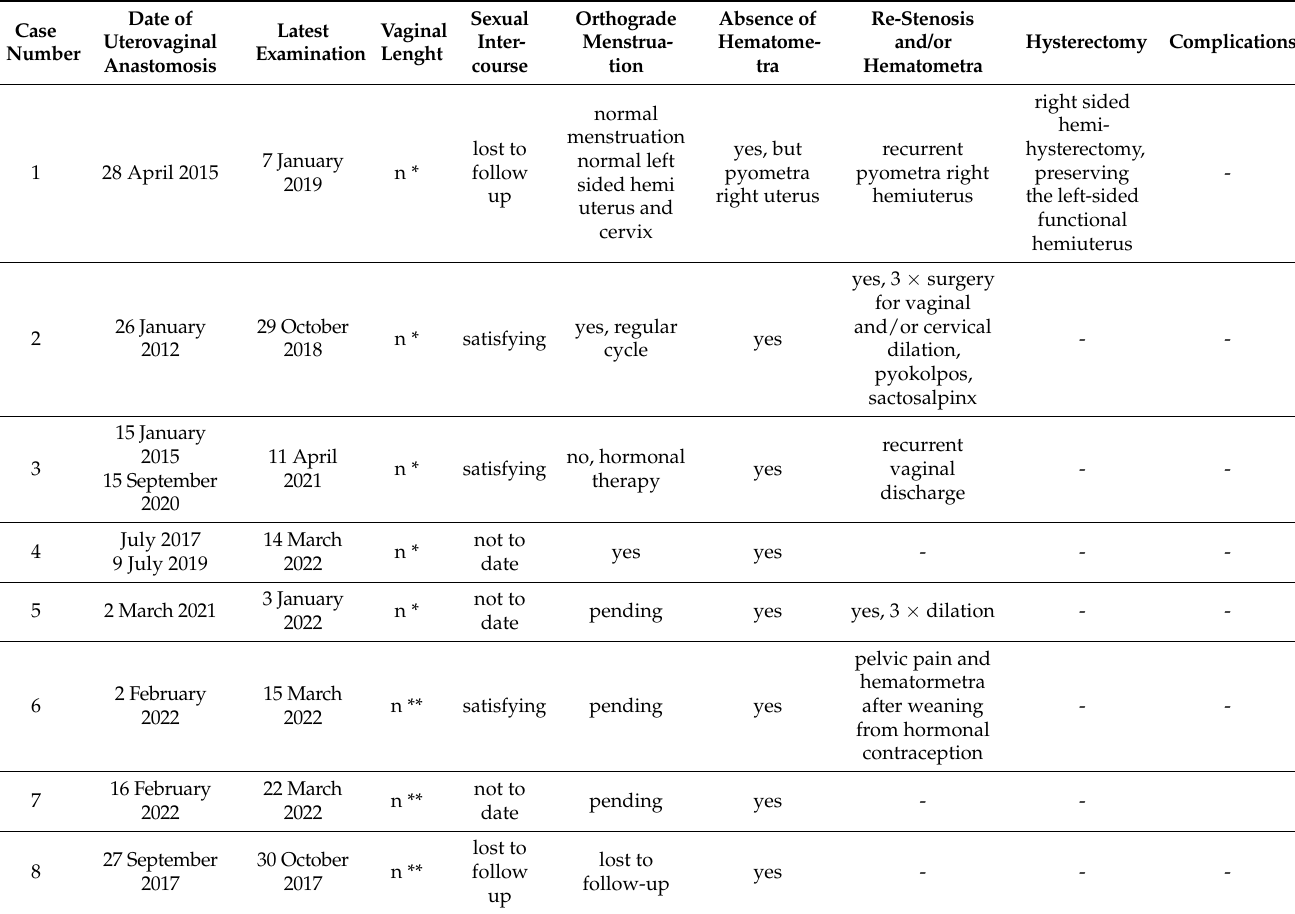
Table 3. Clinical outcome